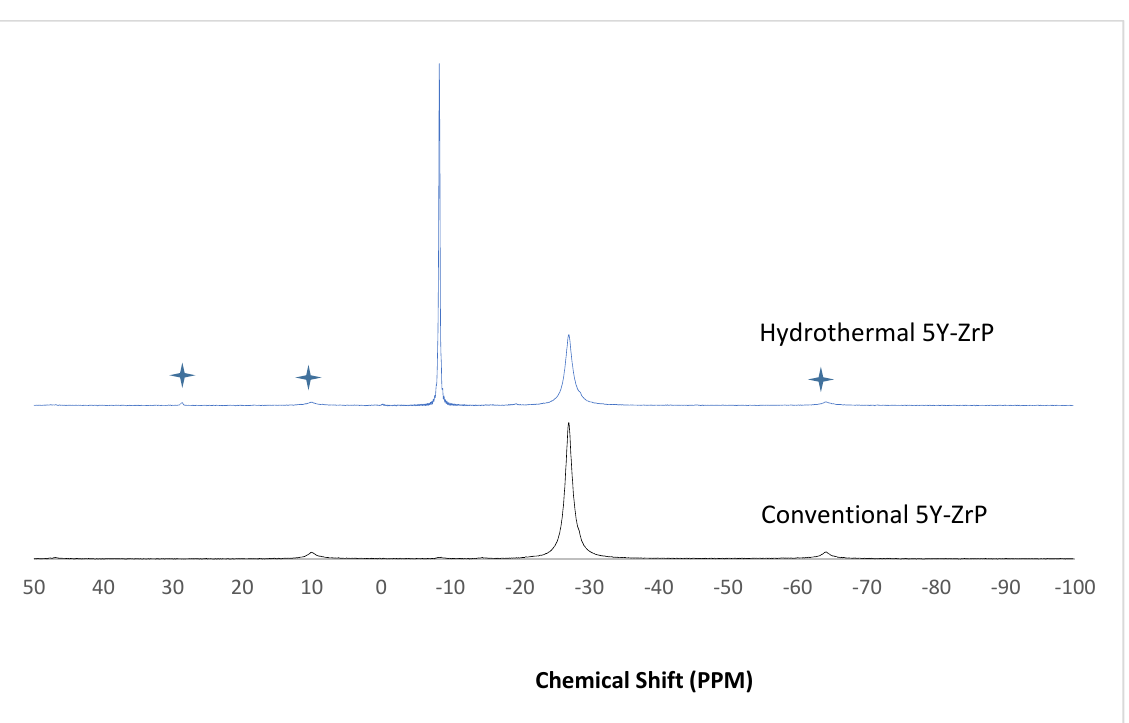
Figure 7. 31 P NMR of 5Y-ZrP synthesised using the two described methods (spinning side bands are shown as ).